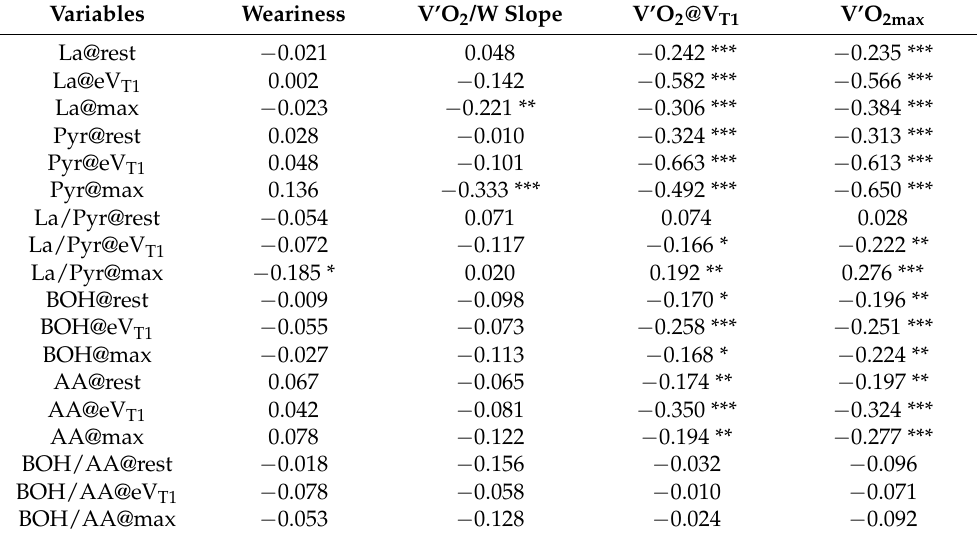
Table 1. Univariate Pearson’s correlation of physiologic exercise parameters with plasma biological parameters measured at each time point (@rest: resting value; @eV T1 : at estimated first ventila- tory threshold; @max: at the acme of effort) in healthy and muscle complaint subjects ( n = 240).